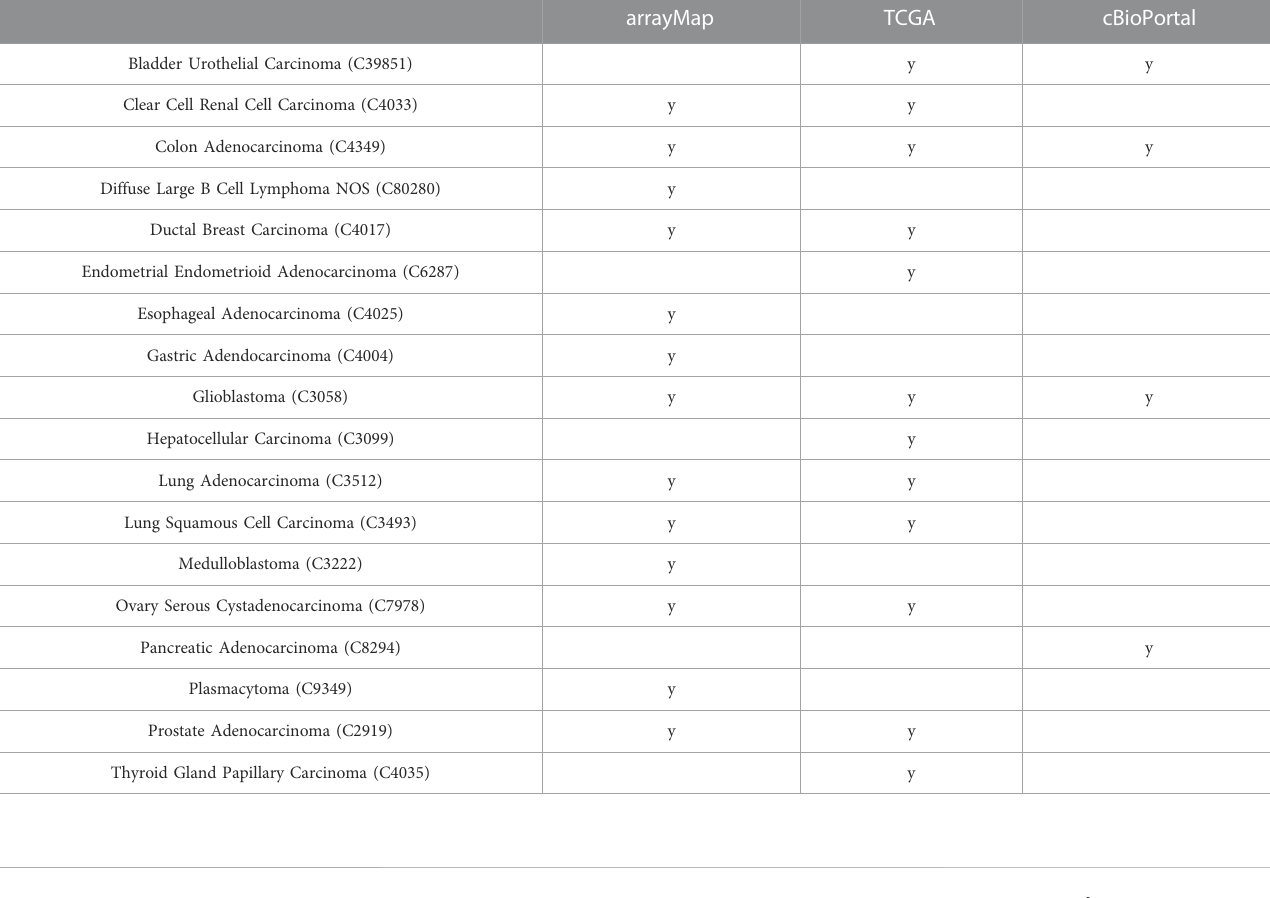
TABLE 1 Analyzed cancer types across data sources.